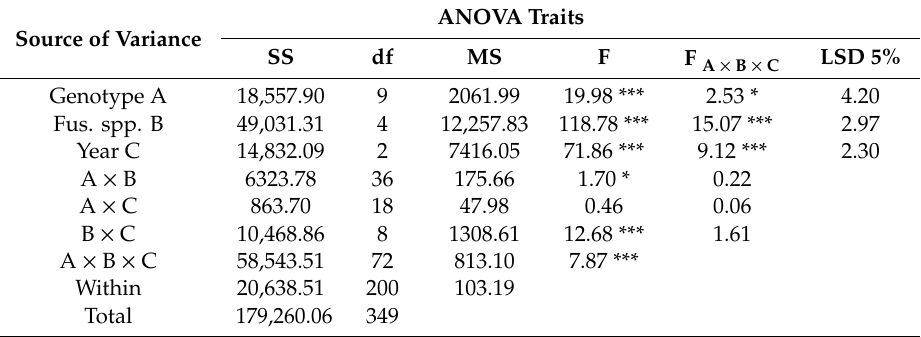
Table 14. Toxin contamination in KR resistance test, ( n = 10), ANOVA of data from Table 12. Source of Variance